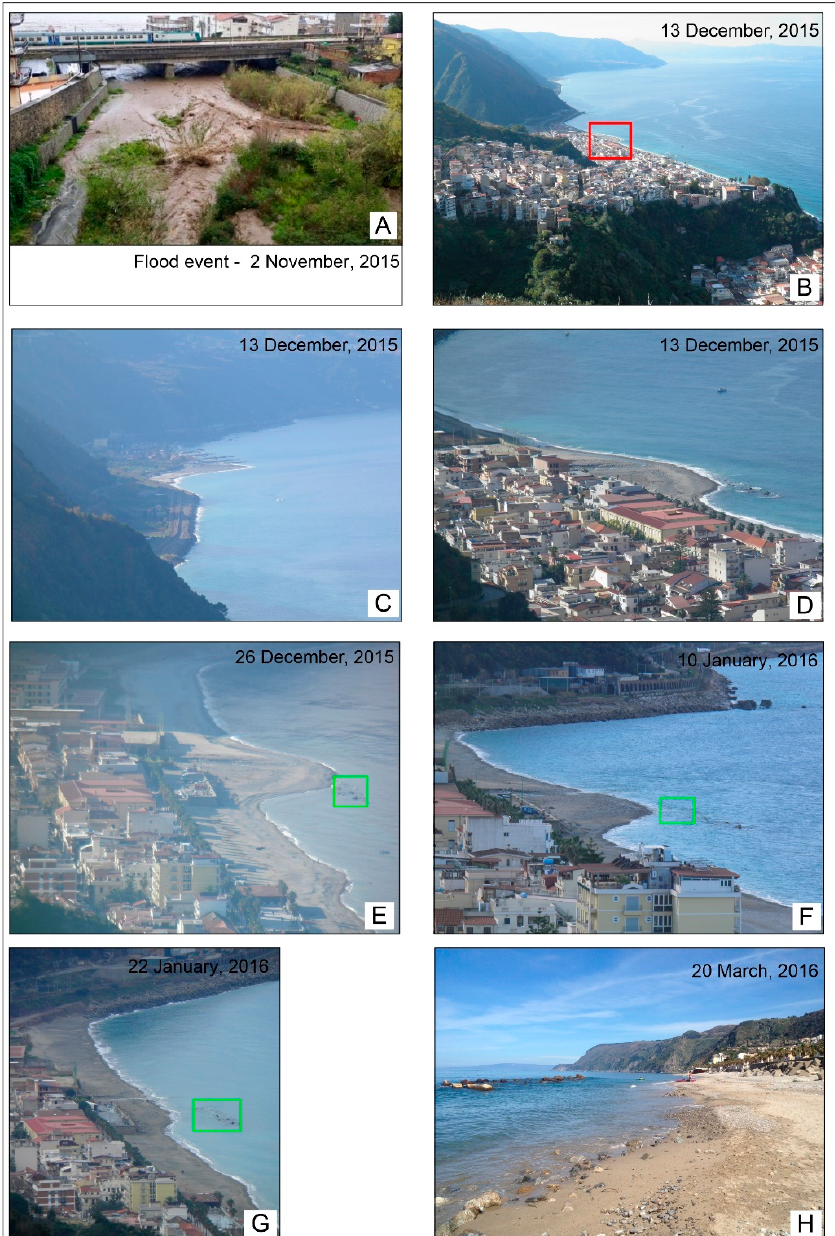
Figure 9. The figures show: (i) the high sediment load of Sfalassà Stream during the flooding event ( A ); (ii) the fan delta location ( B ); (iii) the fan delta morphology after the storm surge of 25–28 November 2015 ( C – E ) and after those occurred from 3 to 8 ( F ) and from 12 to 18 January 2016 ( G , H ). Source: own elaboration on the basis of our photos.